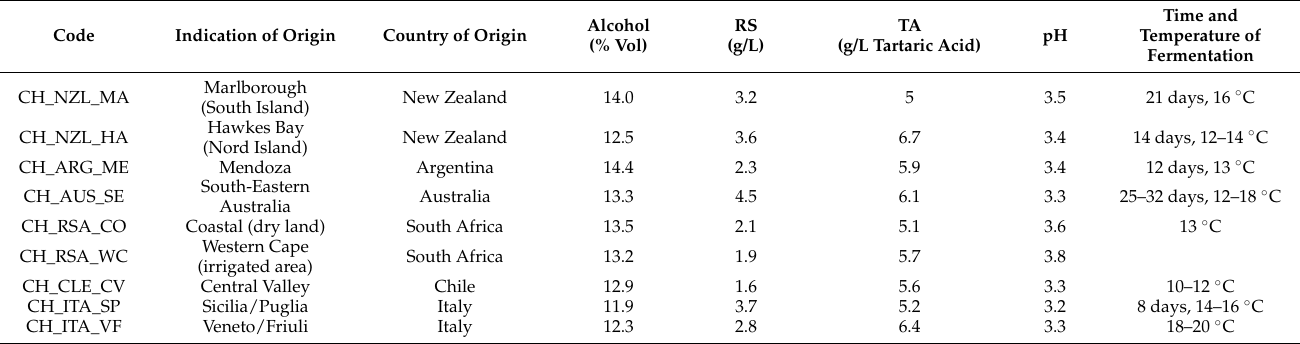
Table 1. Code, origin, and basic oenological parameters of Chardonnay samples (RS, residual sugars; TA, titratable acidity). The alcohol degree (%vol), RS (g/L), and TA (g/L tartaric acid) were analysed by official methods according to OIV [12].